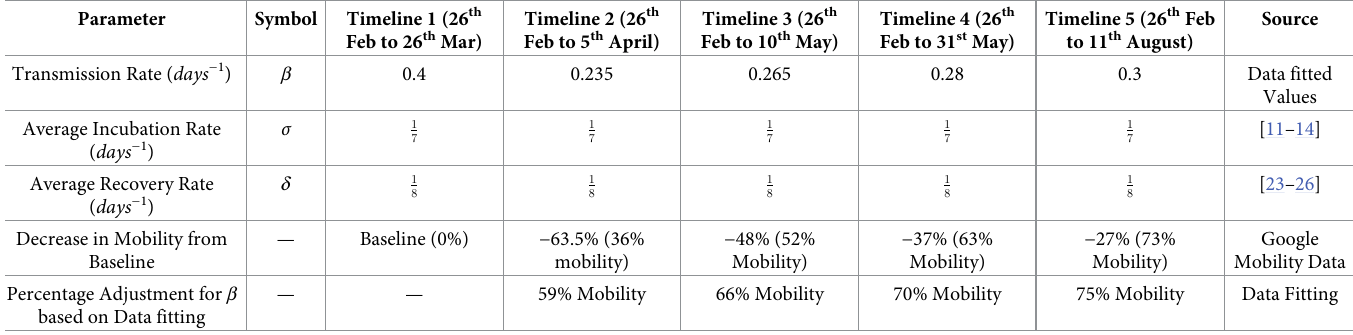
Table 1. The table shows the parameter values used in the SEIR model, parameter values of transmission rate have been calculated from the accuracy of fitted data curves whereas the incubation rate and the recovery rate have been averaged out to 7 and 8 days respectively based on the values obtained from various